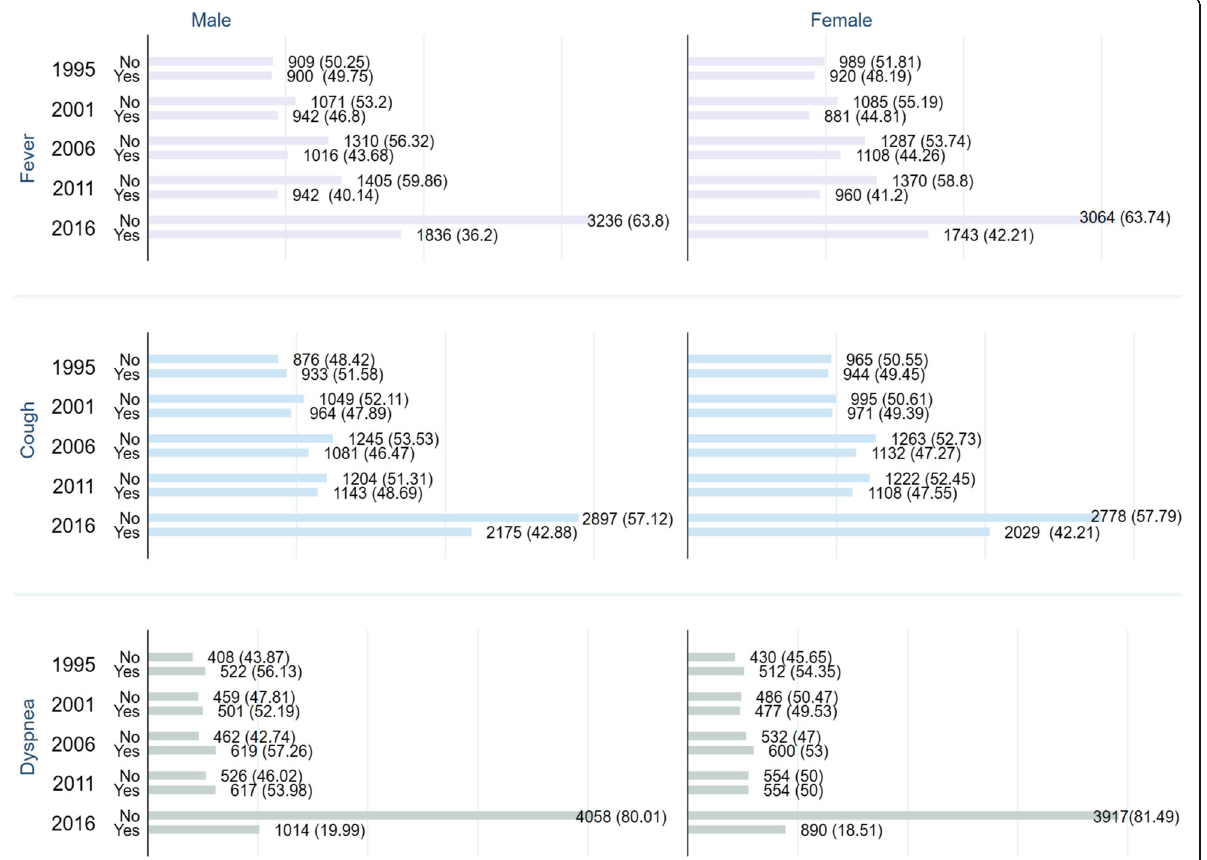
Fig. 1 Secular trend in the prevalence of fever, cough and dyspnea among Ugandan infants between 1995 and